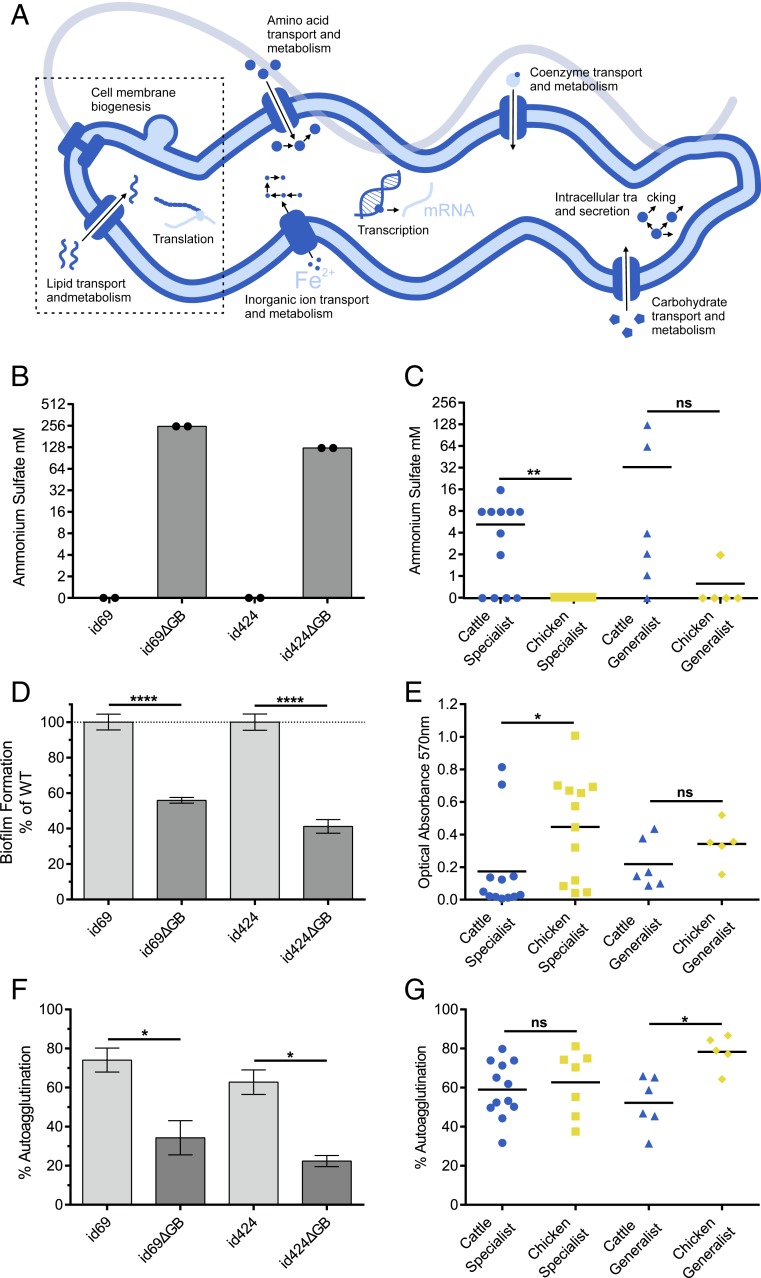
Evidence of cattle associated phenotype variation in C. jejuni. (A) Summary of cattle adaptation based on comparative genomics indicating biological pathways associated with deletion of the glycosylation gene block. (B–G) Phenotype assays comparing two WT chicken specialist strains, id69 and id424 (Dataset S1) and isogenic glycosylation gene block deletion mutants (id69ΔGB and id424ΔGB), and natural specialist and generalist strains from cattle and chicken. (B, D, and F) Chicken-associated lineage mutants show a marked decrease in cellular hydrophobicity, biofilm formation, and autoagglutination compared to WT strains. In assays of natural strain collections, cattle specialist strains show significantly greater mean ammonium sulfate concentration (millimolar) indicating decreased cell hydrophobicity (C), and significantly decreased ability to from biofilms measured as optical absorbance (at 570 nm) (E). (G) No difference was observed in autoagglutination in specialist strains from cattle and chicken, but generalist strains from cattle showed decreased ability to autoagglutinate. Significance was tested using Mann–Whitney U test: *P < 0.05, **P < 0.01, and ****P < 0.001. The horizontal line in each plot represents the mean value.